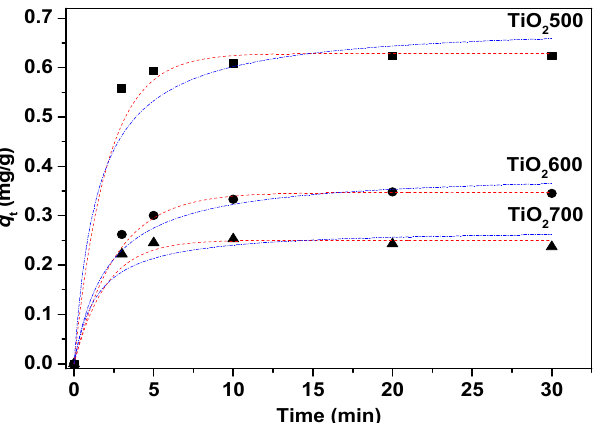
Figure 6. SEM images of the flax template ( a – c ) and fibrous TiO 2 600 ( d – f ).